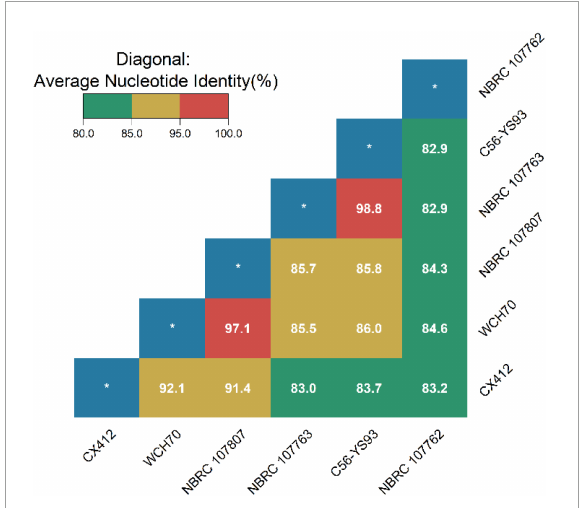
FIGURE3 The average nucleotide identity (ANI) values (%). CX412, Geobacillus sp. CX412; WCH70, Geobacillus sp. WCH70; NBRC 107807, Parageobacillus toebii NBRC 107807; NBRC 107763, Parageobacillus thermoglucosidasius NBRC 107763; C56-YS93, Parageobacillus thermoglucosidasius C56-YS93; NBRC 107762, Parageobacillus caldoxylosilyticus NBRC 107762. *Represents self-ANI analysis with a theory of 100.